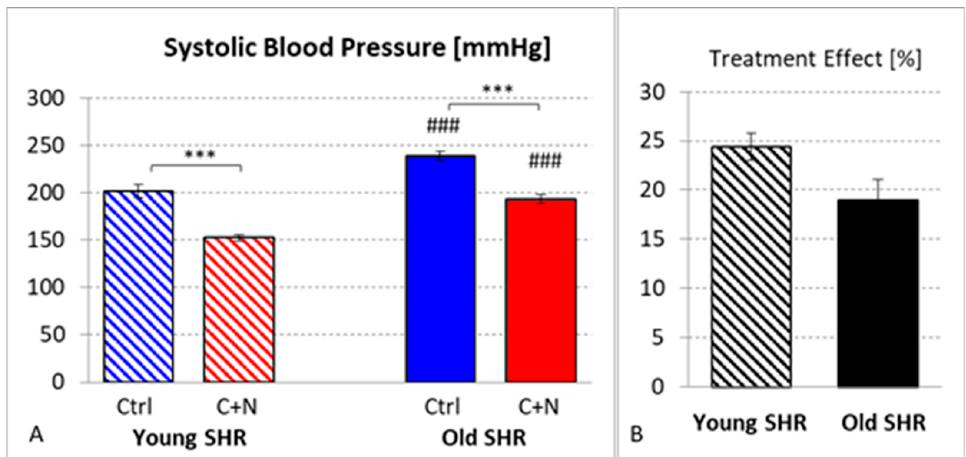
Figure 1. ( A ) Systolic blood pressure (in mmHg) at 10 (young SHR) or 82 (old SHR) weeks of age in untreated (Ctrl) and treated (captopril + nifedipine, C+N) SHRs. ( B ) Treatment effects in young and old SHRs (in % of corresponding average Ctrl value). Significance marks: ⎾ * ⏋ significant difference between marked groups, *** p < 0.001; ### significant difference to corresponding young SHR group, p < 0.001.